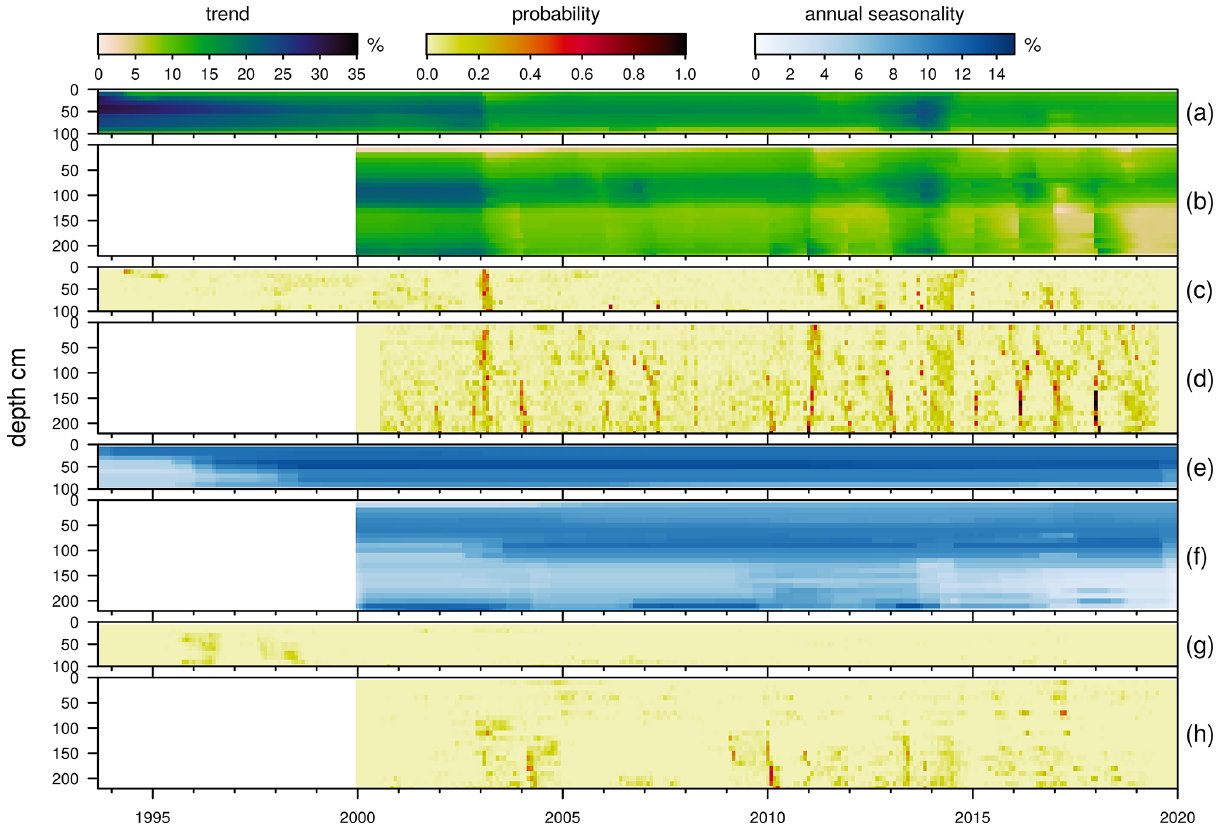
Figure 12. Results of modeling soil moisture at NP5 and NP10 with Rbeast. (a) Trend component of soil moisture time series at NP10 in Field 1. (b) Trend component of soil moisture time series at NP5 in Field 2. (c) Probability of a change point in the trend component at NP10 in Field 1. (d) Probability of a change point in the trend component at NP5 in Field 2. (e) Amplitude of annual seasonality derived from the seasonal component at NP10 in Field 1. (f) Amplitude of annual seasonality derived from the seasonal component at NP5 in Field 2. (g) Probability of a change point in the seasonality component at NP10 in Field 1. (h) Probability of a change point in the seasonality component at NP5 in Field